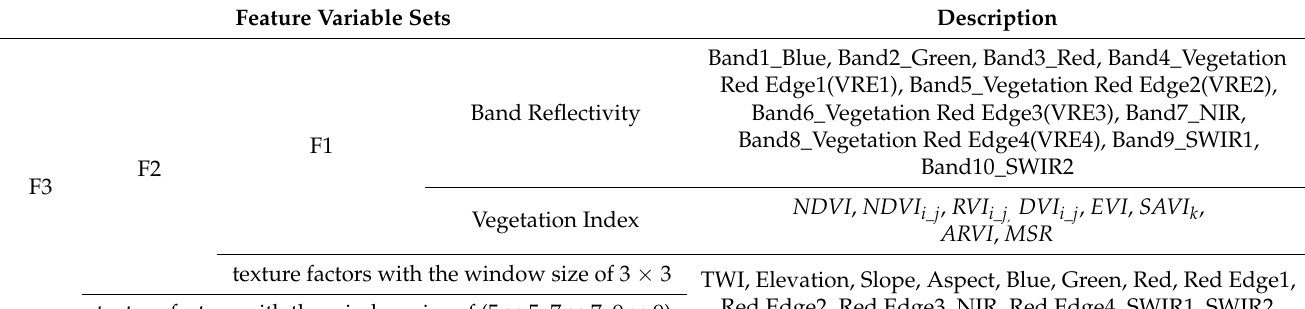
Table 4. Feature variable sets used in this research. Texture factors of GLCM, including mean, variance, homogeneity, contrast, dissimilarity, entropy, second moment, and